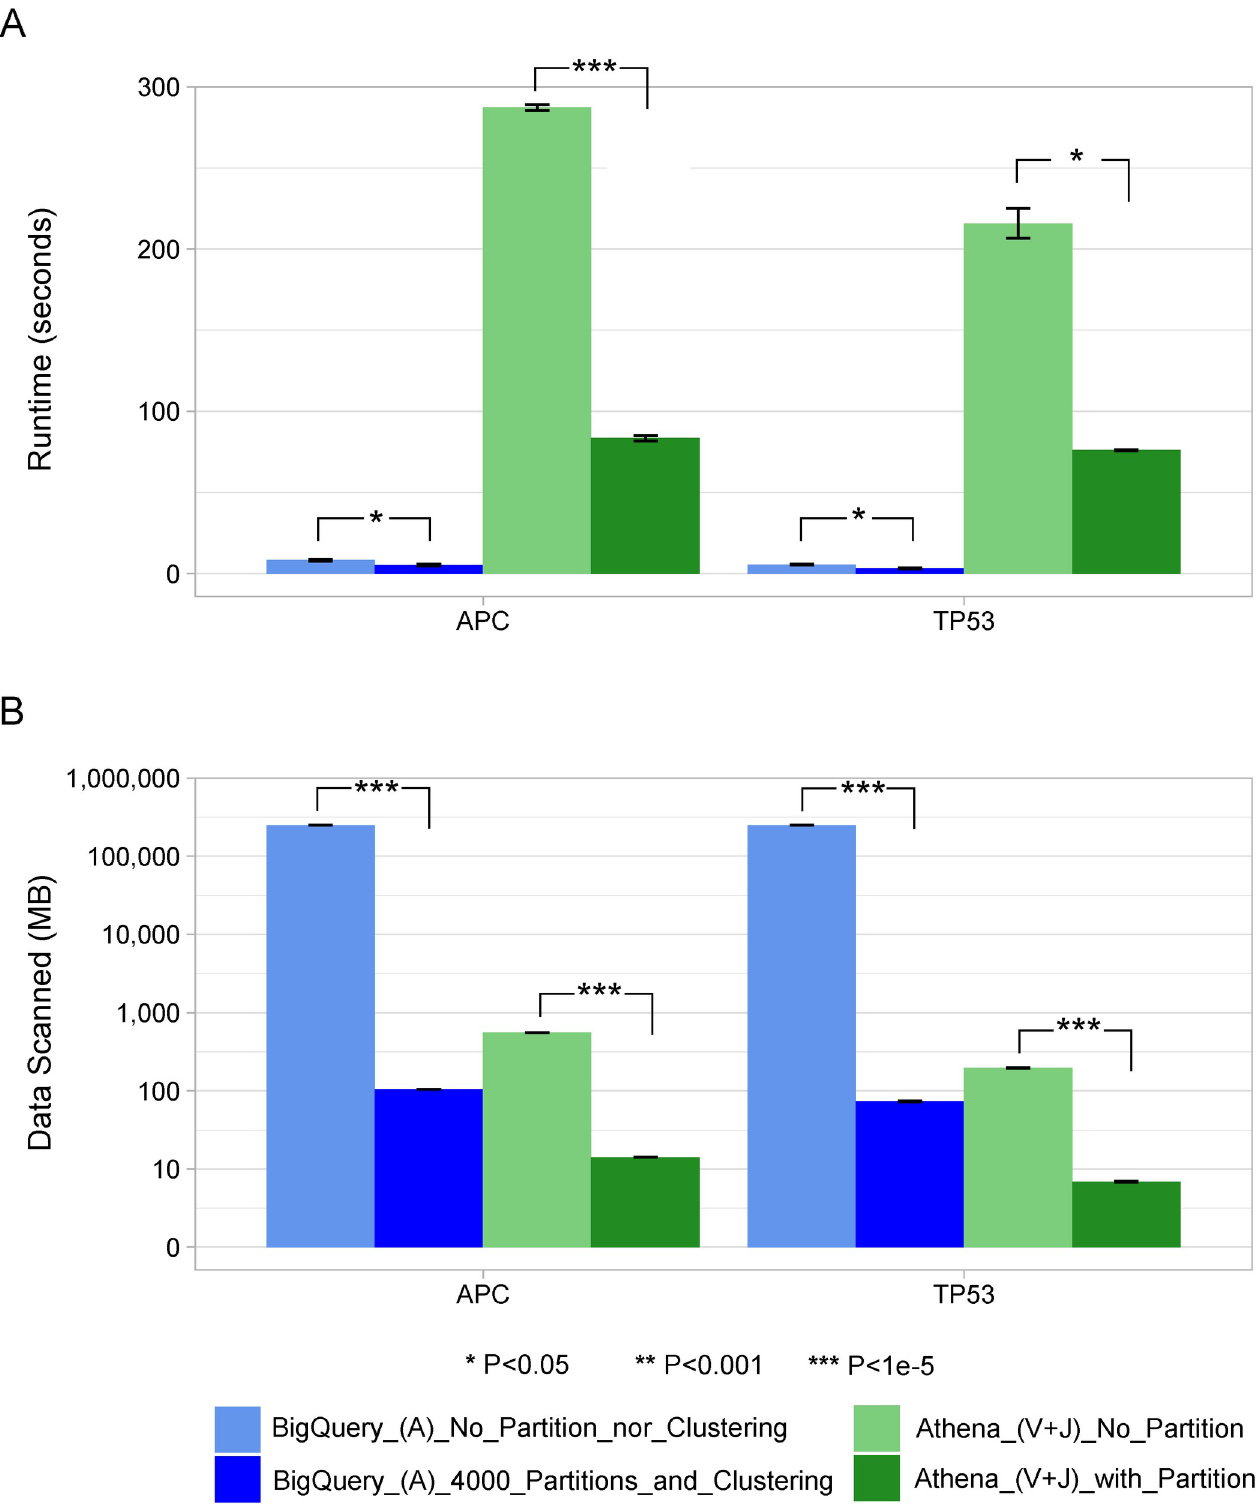
Fig 3. Runtime and the amount of data processed for annotating an input set of genes. A, V and J stand for Annotation records, Variant records and Join table operations, respectively. Average values and standard deviations were plotted. ( A ) depicts the execution time in seconds for the two input genes. In this experiment, the annotation table was in BigQuery and the variant table in Athena. Therefore, Swarm first found all the annotation records in BigQuery that